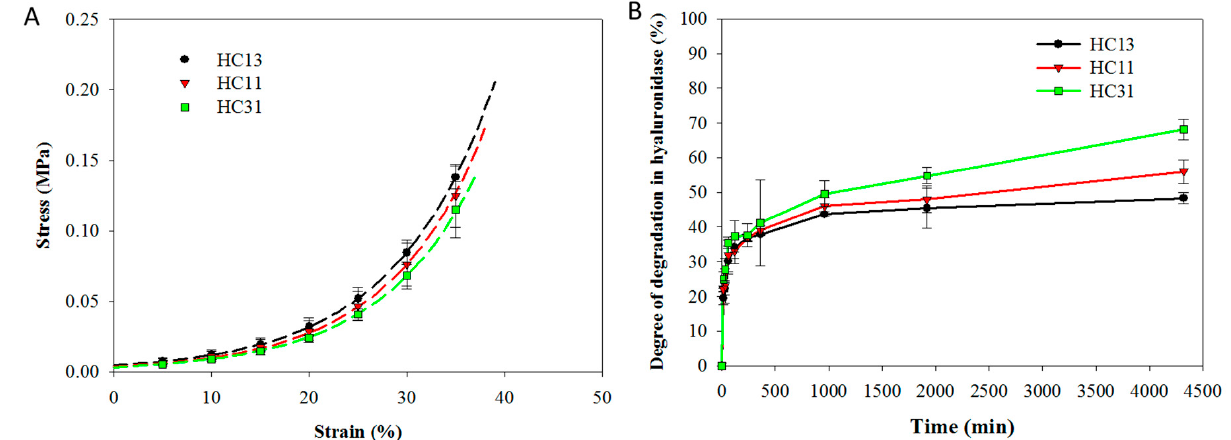
Figure 4. The typical stress-strain curves from unconfined compression tests ( A ) and the degradation in hyaluronidase (700 U/mL) solution ( B ) of HA/CMC hydrogel prepared at 1/3 (HC13), 1/1 (HC11) and 3/1 (HC31) mass ratios of HAMA/CMCMA. Table 1. The mechanical properties from unconfined compression tests of HA/CMC